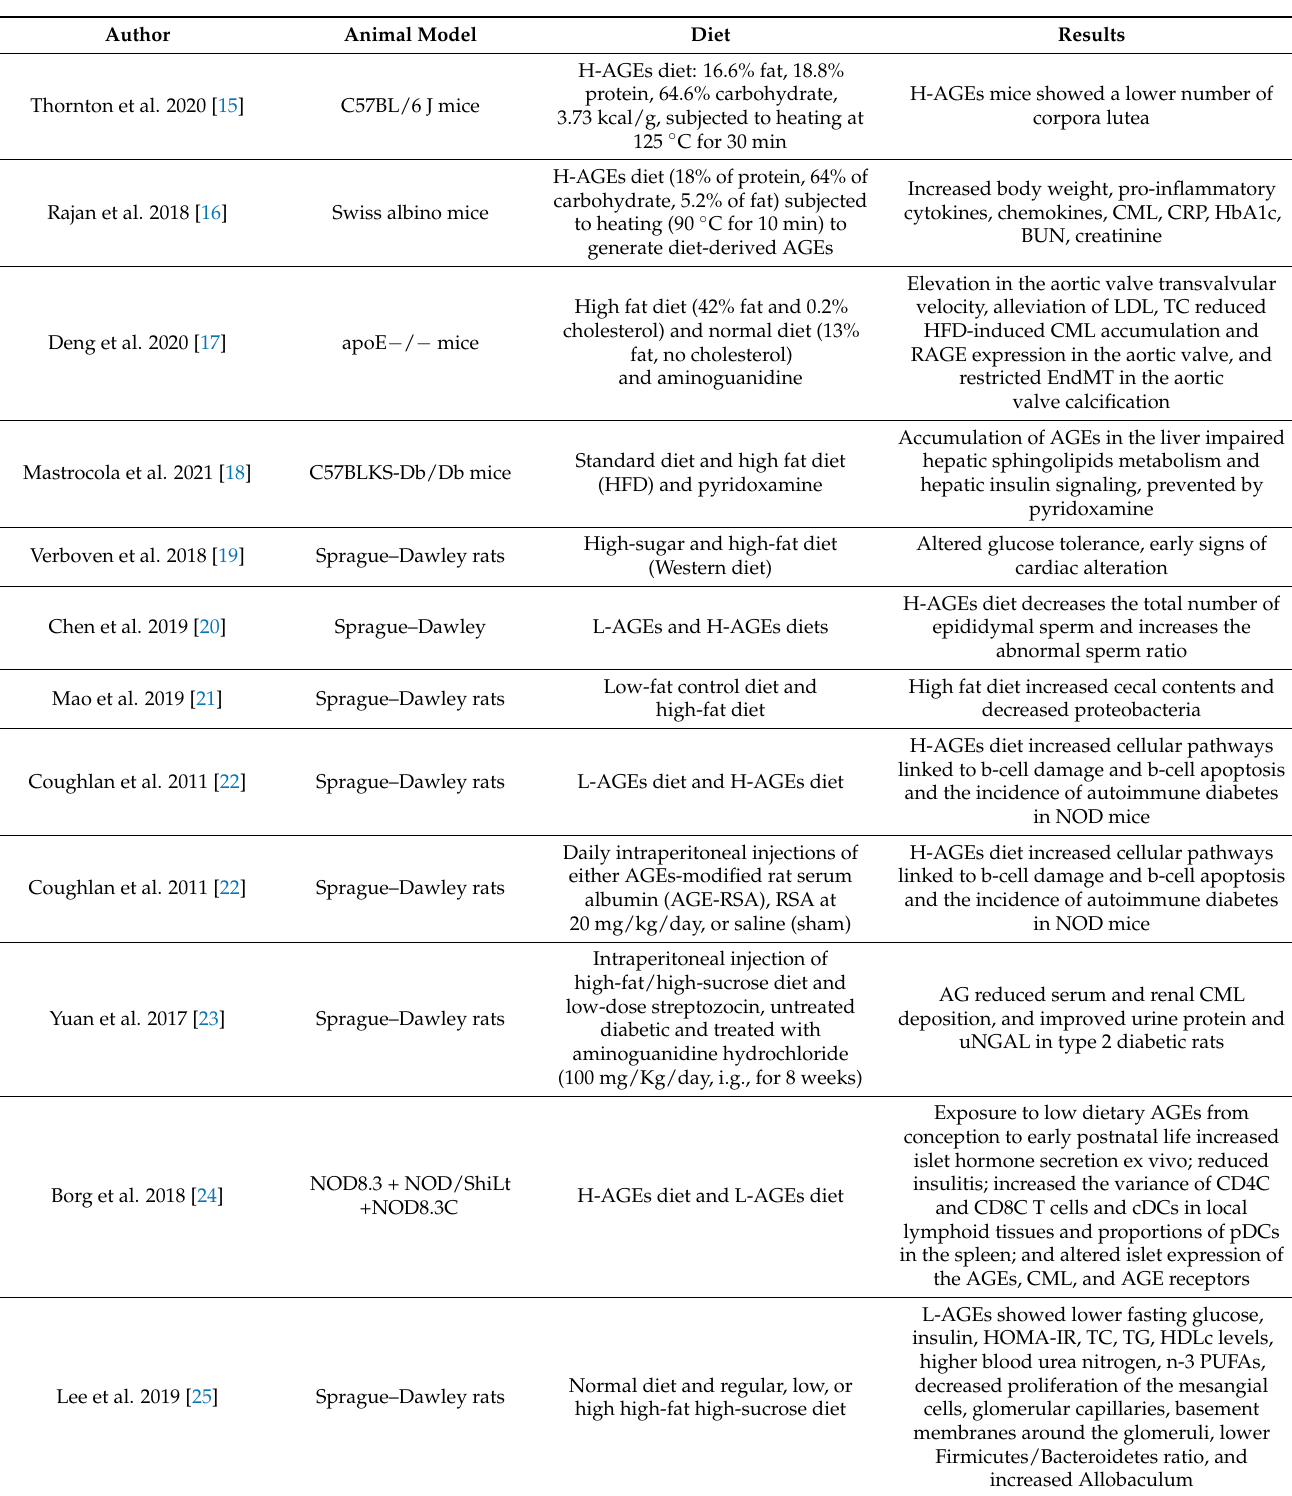
Table 1. Summary of dAGEs-related animal